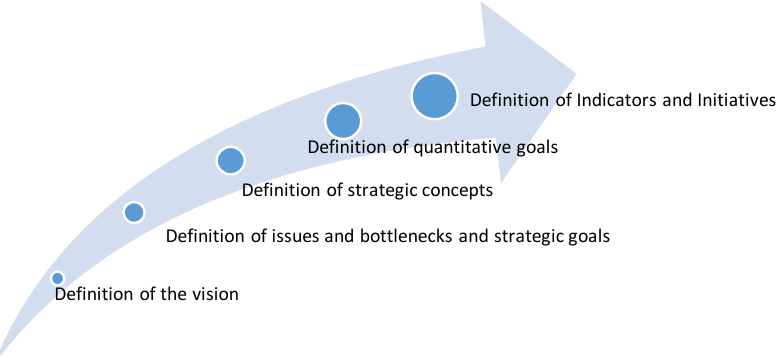
Figure 3 . The alignment of the vision and its impact on indicators and initiatives